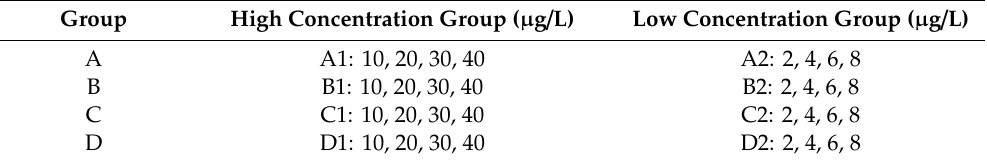
Table 1. Grouping of experimental